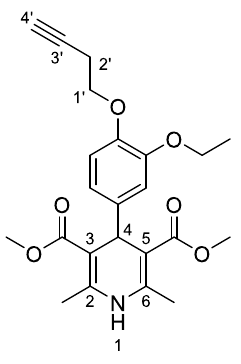
Figure 16. Chemical stucture of 3o .